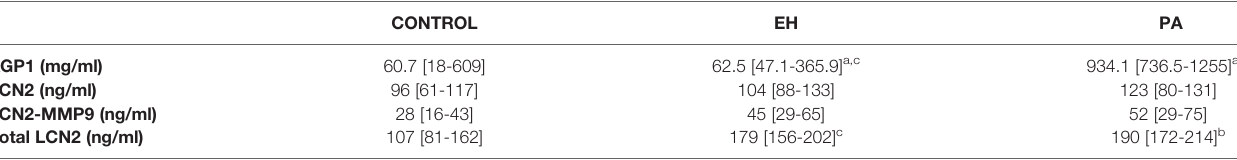
TABLE 3 | Determination of serum AGP1A, LCN2, and LCN2-MMP9 in PA subjects.